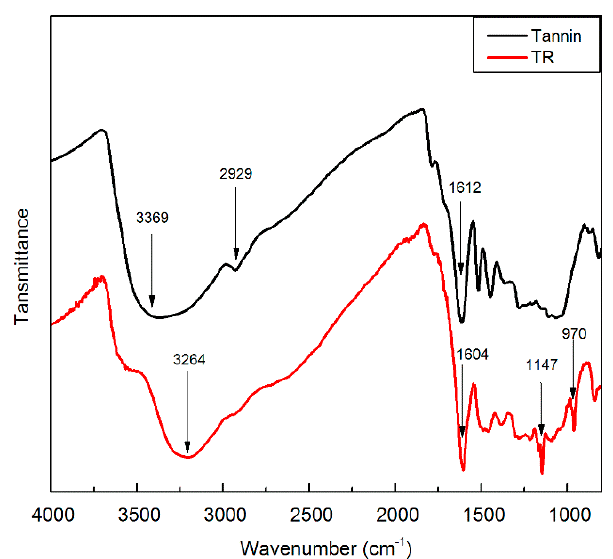
Figure 1. FTIR spectra of tannin/TR.